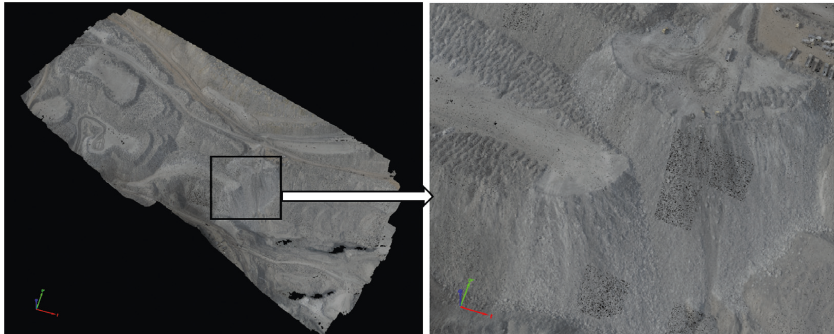
Figure 7: Active waste dumping zone in the study area.